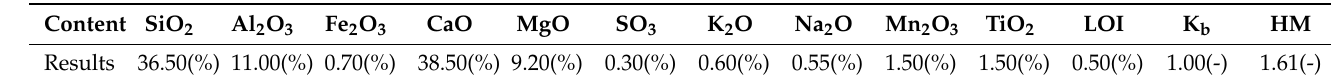
Figure 1. Raw materials ( a ) slag ( b ) fine aggregates ( c ) coarse aggregates ( d ) RTSF. Table 1. Chemical properties of